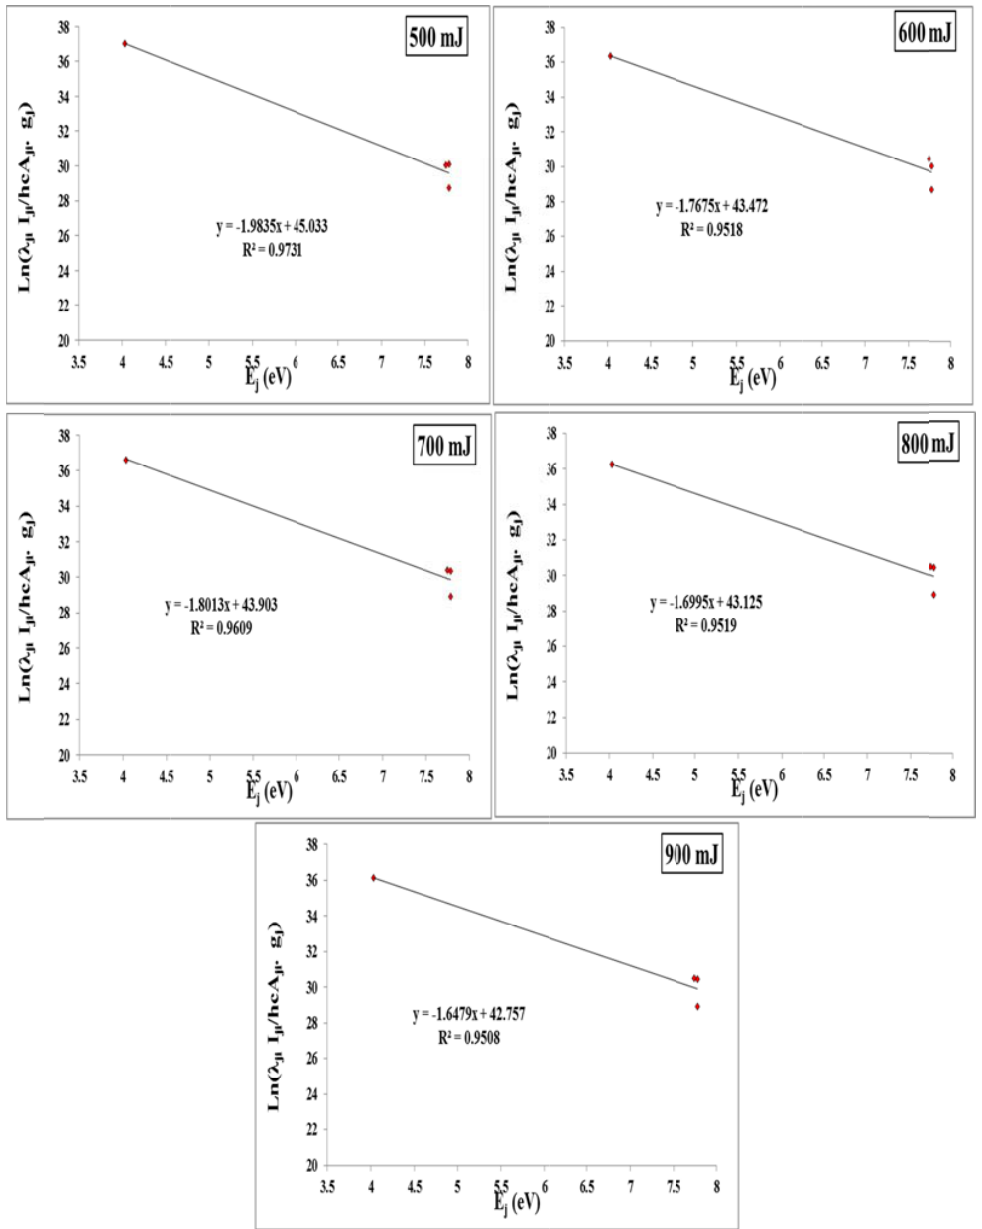
4: Boltzman nn plot for p lasma emiss ener rgy.